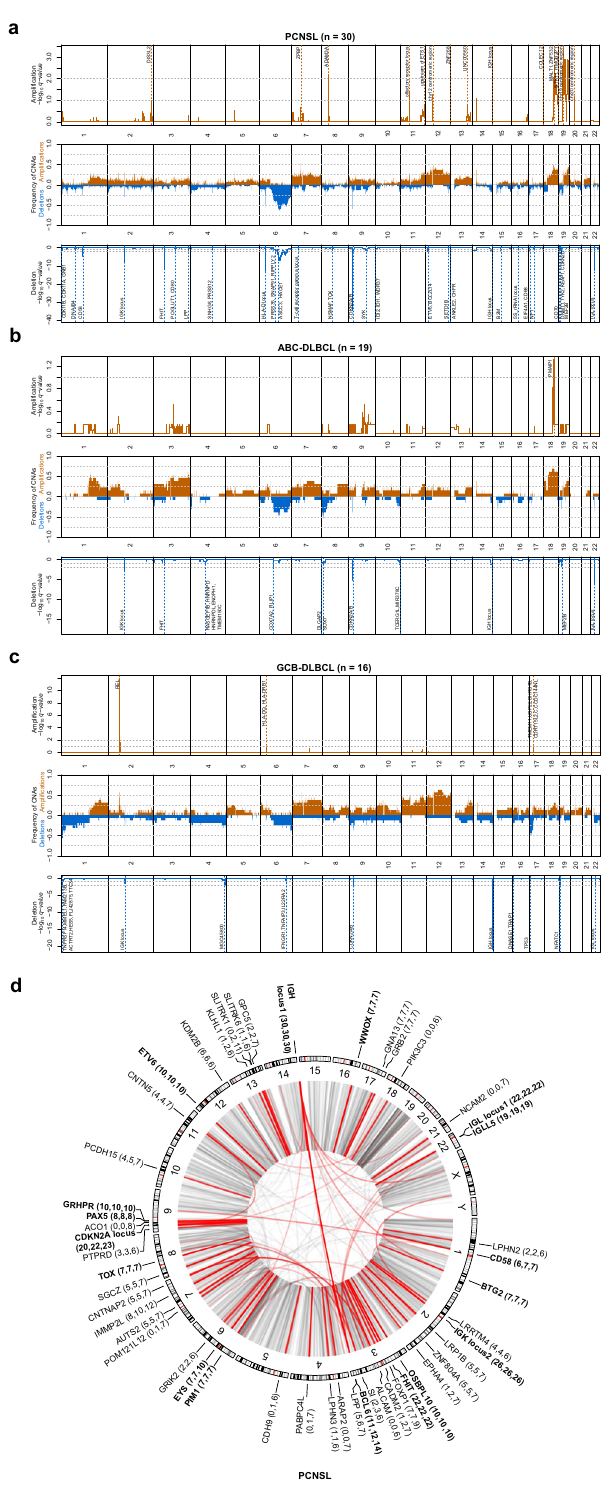
Fig. 4 Genomic structural variation in PCNSL. Recurrent somatic CNAs in PCNSL ( a ), ABC-DLBCL ( b ), and GCB-DLBCL ( c ). Relative prevalence of somatic copy number aberrations in tumor samples (middle panel), showing the presence of at least one copy number gain (orange bars), copy number loss (blue bars), as a proportion of analyzed samples. Signi fi cantly ( q -value < 0.25) ampli fi ed and deleted regions and candidate genes are shown (upper and lower panel). For GCB-DLBCL, we added TP53 as this was detected in a signi fi cant broad deletion (Gistic2 p -value 0.0311), and the focal peak falls on the region including TP53 . Circular visualization of genome rearrangements in PCNSL ( d ). The panels (from outside going inwards) represent recurrence per gene, chromosome ideograms, and chromosome numbering. Next to gene names, the number of SV breakpoints that lie direct on the gene, within 100 kbp of the genes, and closest to that gene are reported. Inter-chromosomal translocations are rendered with black (all) and red (highlighted if affected in 20% of samples) arcs in the center of the display. The signi fi cance of CNVs was calculated using the GISTIC 2.0 permutation test with Benjamini – Hochberg correction for